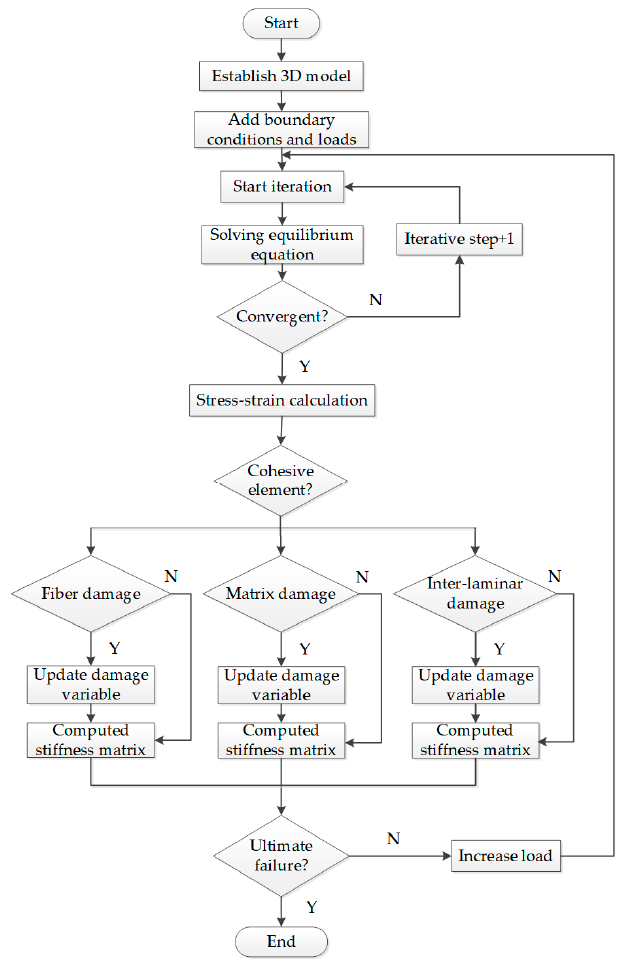
Figure 7. Schematic diagram of the delamination damage structure model.